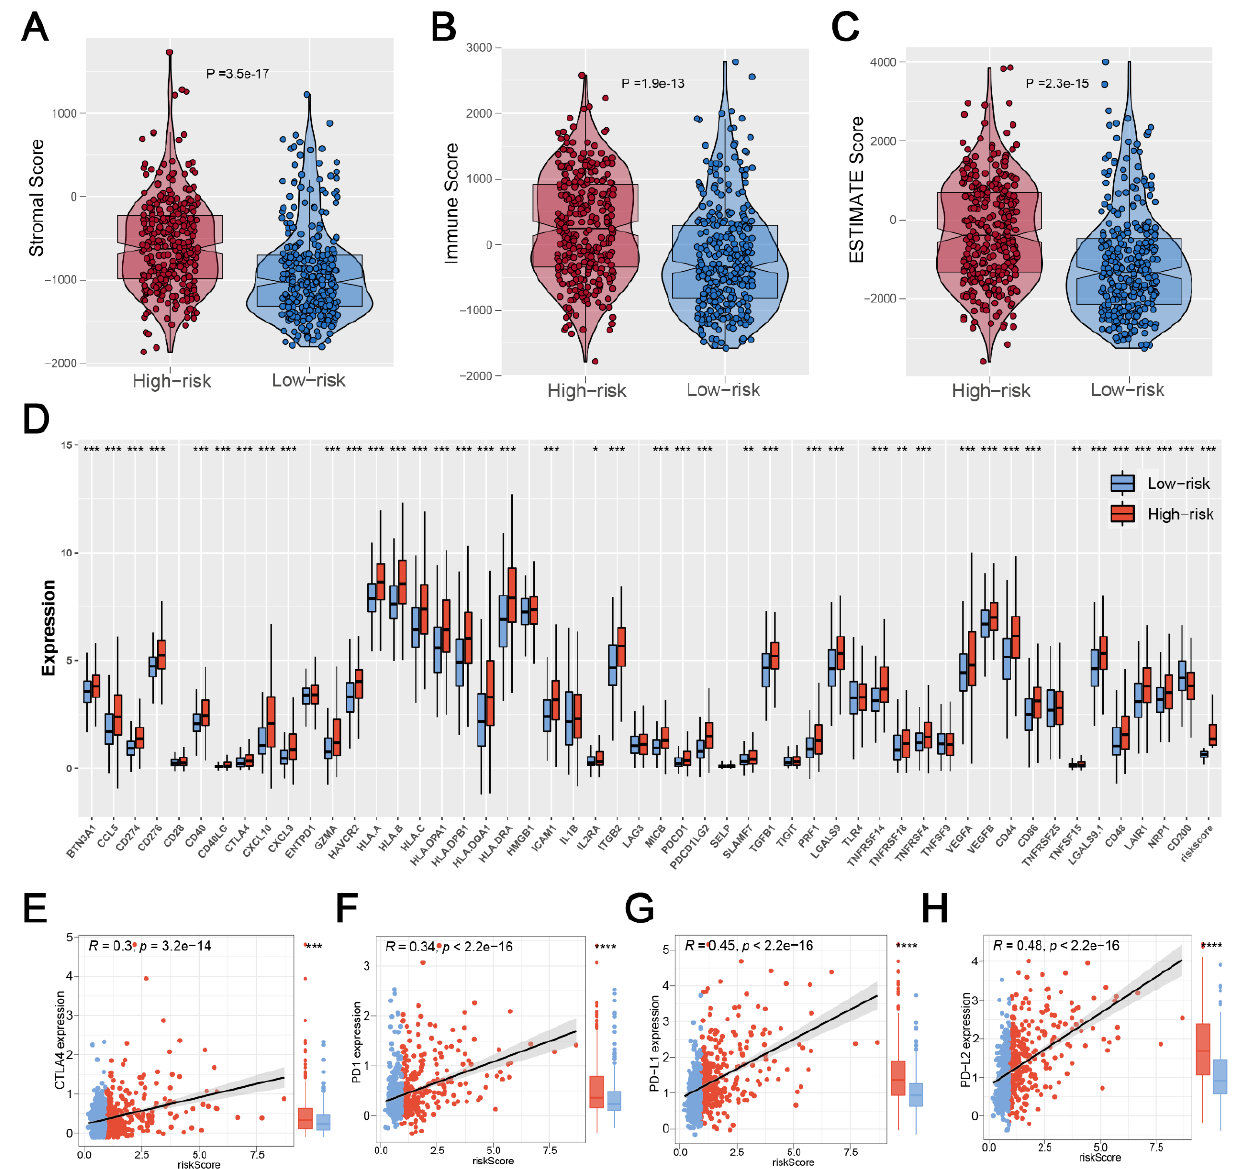
Figure 6. Exploration of the difference in immune features. Notes: ( A – C ) Patients with high risk scores showed a higher level of the immune score, stromal score, and estimate score; ( D ) The heatmap of 52 immune-checkpoint-related genes expression between two risk groups; ( E – H ) Patients with high risk score showed a higher level of CTLA4, PD1, PD-L1, and PD-L2, indicating that patients in different risk groups may have a difference in immunotherapy response. (* p < 0.05, ** p < 0.01, *** p < 0.001).